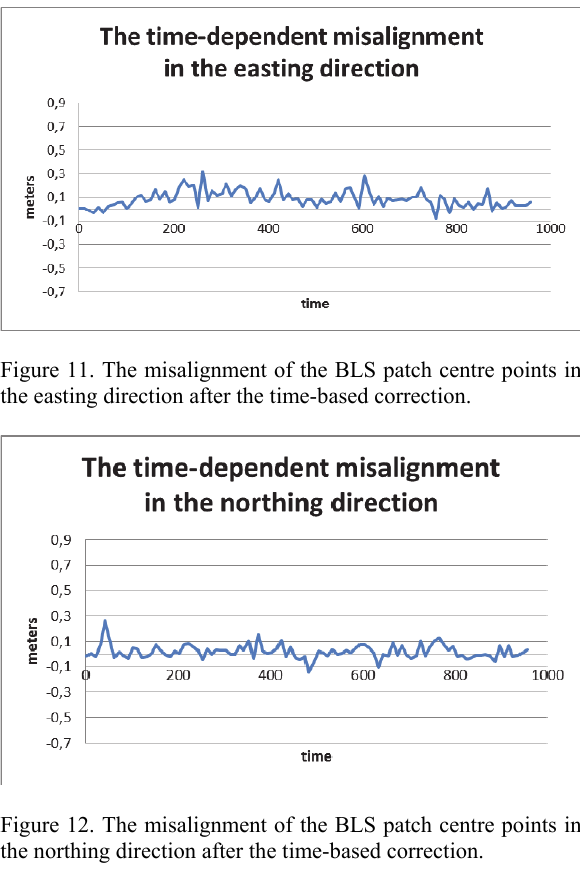
Table 2. The statistics of the misalignments after the time-based correction.